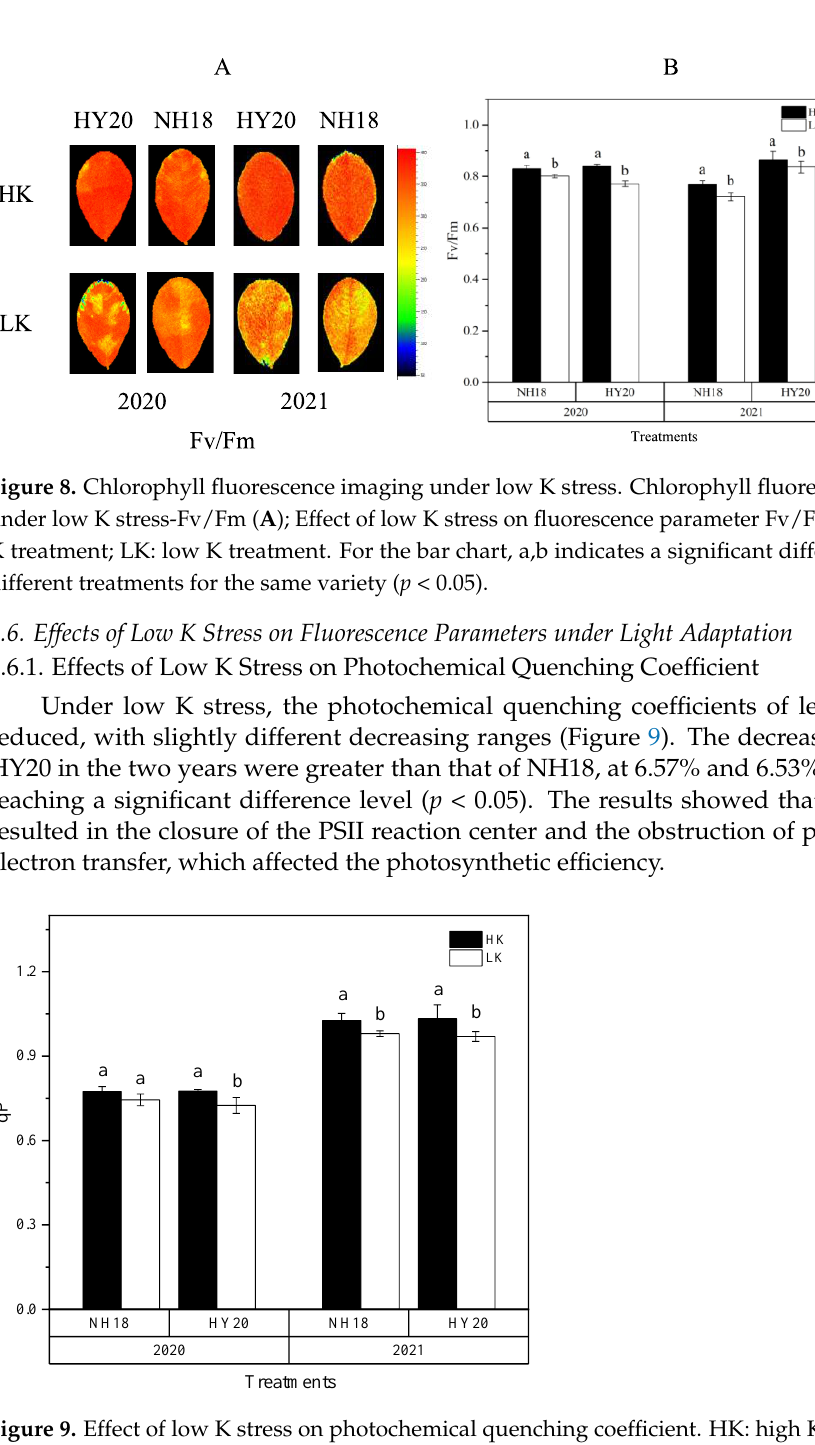
12 of 21 Figure 7. Effects of low K stress on fluorescence parameters of dark adaptation. HK: high K treatment; LK: low K treatment. For the bar chart, a,b indicates a significant difference between different treatments for the same variety( p < 0.05). Fv/Fm is the maximum photochemical quantum efficiency of PSII, which is used to reflect the potential photochemical capacity of plants. Under low K stress, there were partial yellow or bluish-colored areas in the Fv/Fm fluorescence imaging effect diagram (Figure 8A). By comparing the color scale, it could be seen that the Fv/Fm value of these areas was significantly lower than that under the high K treatment. Fv/Fm decreased